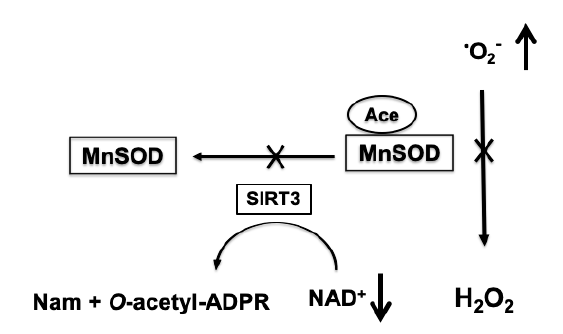
Figure 3. NAD + -dependent increase in mitochondrial superoxide production ( • O 2- ). Ischemia-induced depletion of mitochondrial NAD + pools leads to reduced activity of SIRT3 that transfers the acetyl group (Ace) from MnSOD to the ADP ribose (ADPR) moiety of NAD + and forms O -acetyl-ADPR and nicotinamide (Nam). The hyperacetylation-induced inhibition of MnSOD results in insufficient removal of superoxide generated by mitochondria causing an increase in ROS levels.